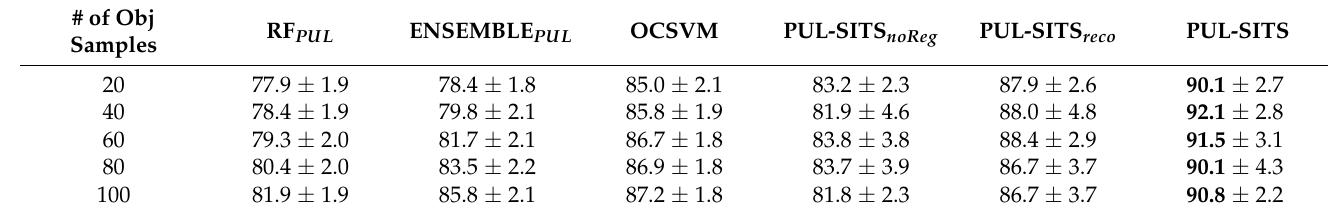
Table 10. Performances in terms of the Accuracy of the different competing strategies when the land cover class of interest (the positive class) is Forest .